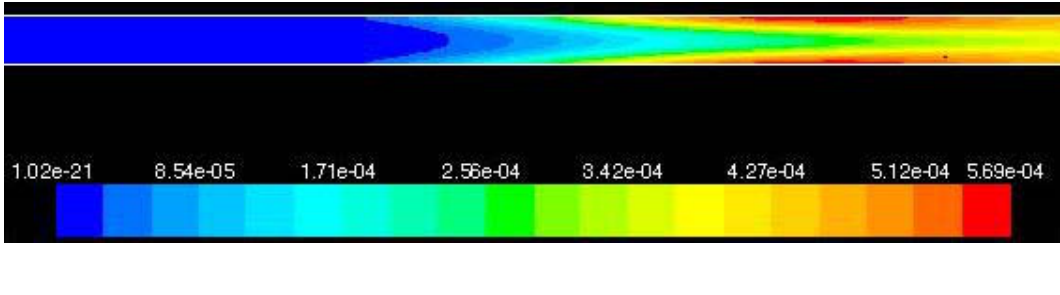
Figure 3. Mole fractions contours of C